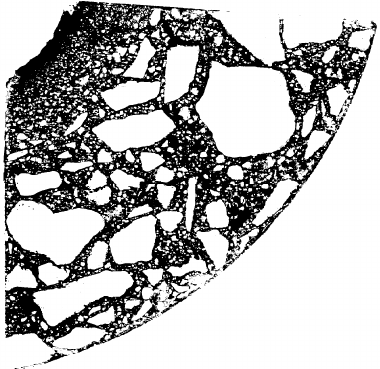
Figure 11. Step 5—product of images from Steps 3 and 4. Materials 2019 , 12 , 1016